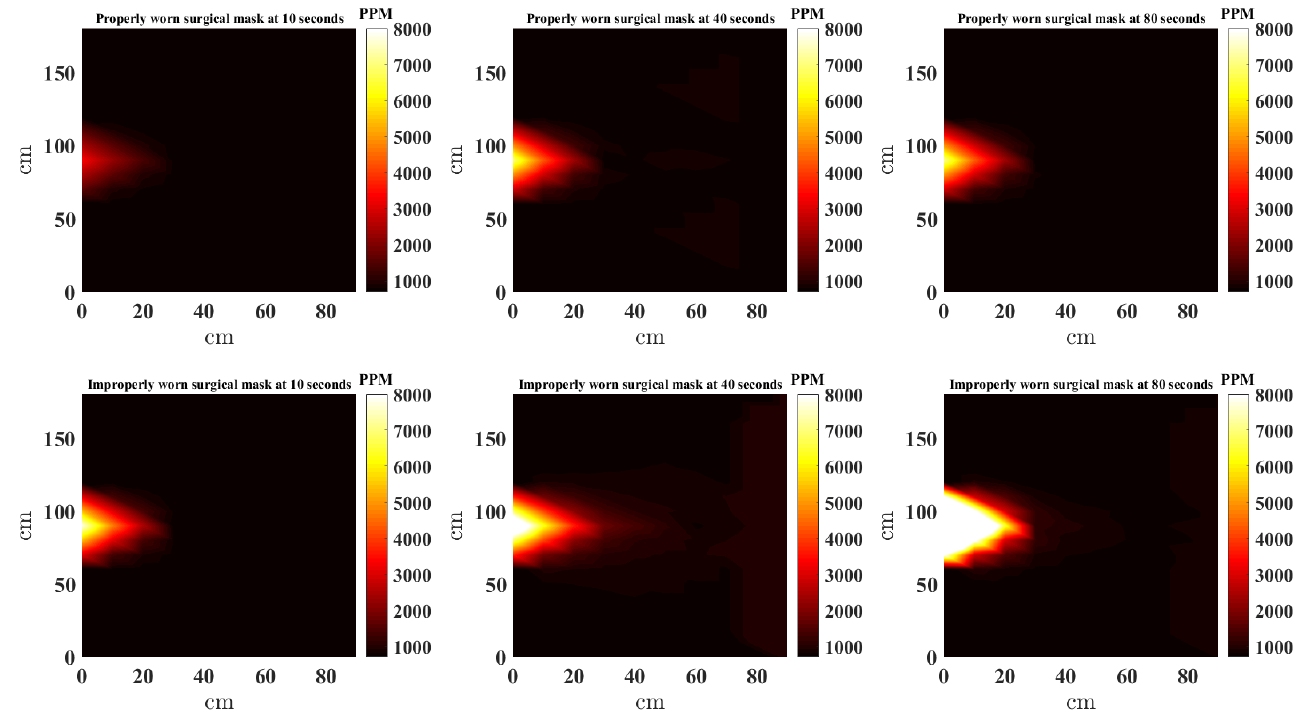
Figure 10. Interpolated CO 2 with properly and improperly worn surgical mask.